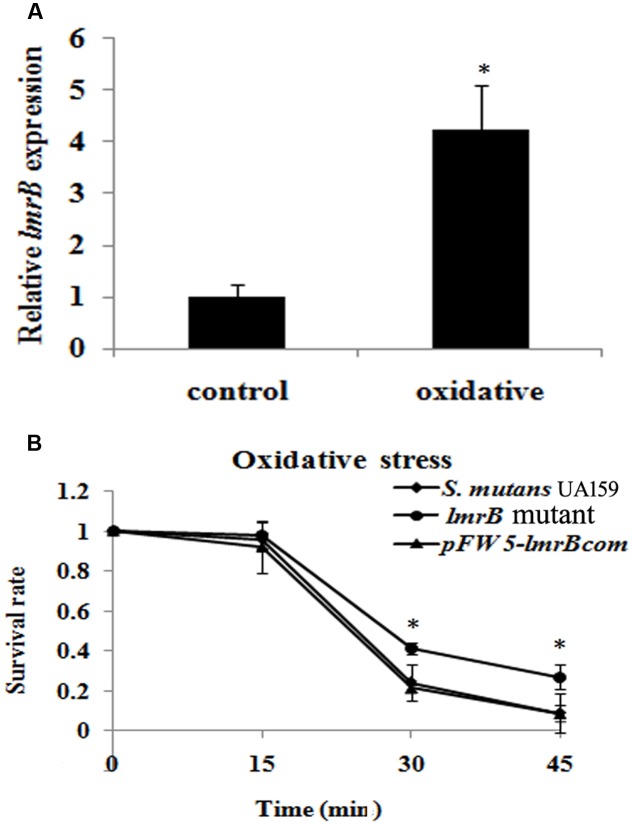
lmrB gene in S. mutans UA159 was involved in response to oxidative stress. (A) Relative expression level of lmrB under oxidative conditions. lmrB expression was normalized to the levels of 16S rRNA gene, and the fold of expression change was calculated. ∗Represented that oxidative stress induced the expression of lmrB significantly (p < 0.05). (B) Oxidative stress assays. H2O2 sensitivity of S. mutans UA159 strains was determined by measuring the survival rate of S. mutans UA159 cells at different time points. ∗Represented that the lmrB mutant was more resistant to H2O2 killing compared with the wild type and complemented strains (p < 0.05).